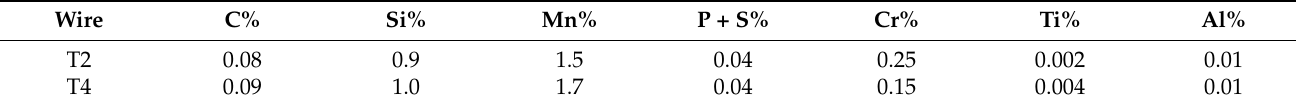
Table 3. Chemical compositions of the electrode wires [6].